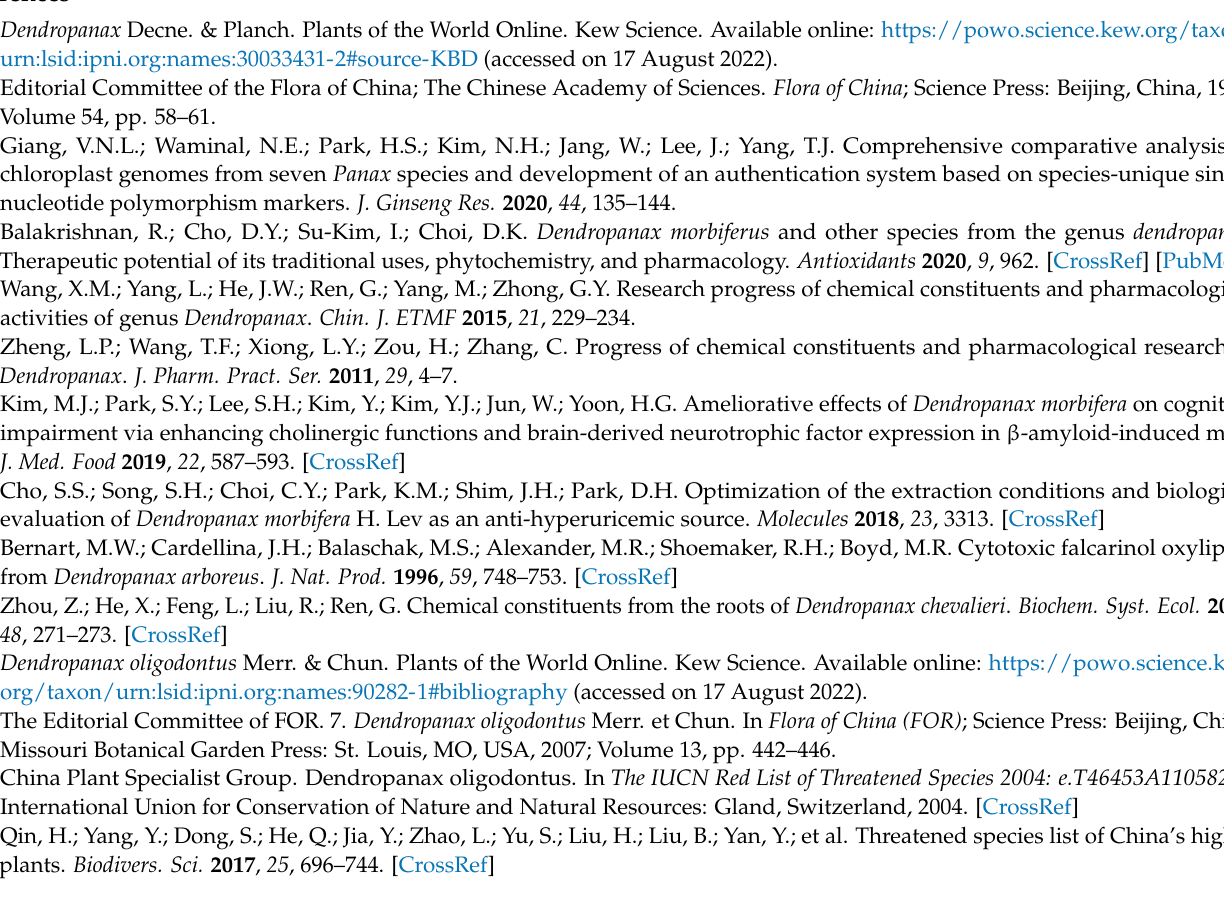
Table S3: The rate of Ka/Ks in the chloroplast genomes of 11 Araliaceae species; Table S4: Plant materials for data